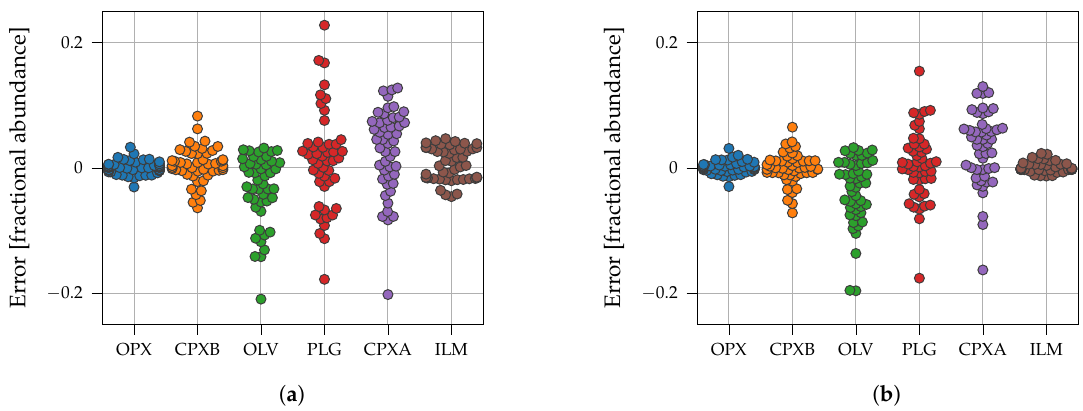
Figure 11. Differences between mean predicted solution and true abundance. The differences in ilmenite and plagioclase abundance can be reduced with a prior on the TiO 2 and Al 2 O 3 abundance. Each circle represents one mixture. ( a ) Without prior; ( b ) TiO 2 and Al 2 O 3 prior.